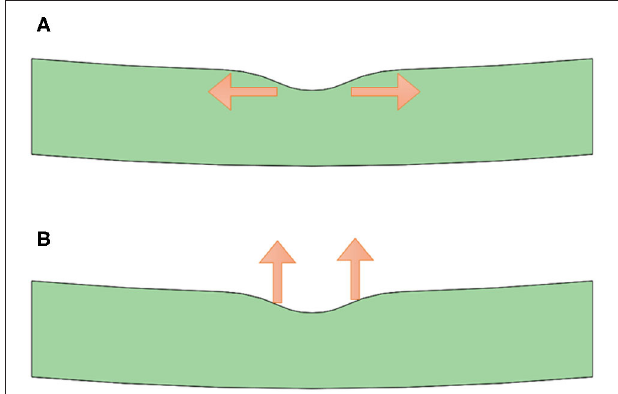
FIGURE 4 | Structure model with forces of different directions applied. (A) Structure model with horizontal force applied (corresponding to the condition of epiretinal membrane); (B) Structure model with vertical force applied (corresponding to the condition of vitreoretinal macular traction).